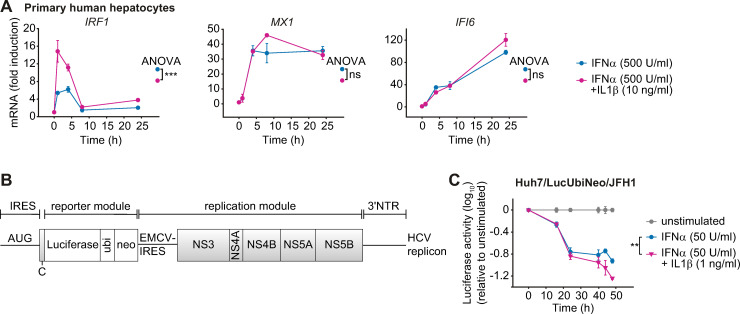
Co-stimulation with IFNα and IL1β enhances IFNα-induced gene expression in primary human hepatocytes and viral clearance of HCV in a replicon cell line.(A) Effect of co-stimulation with IFNα and IL1β on mRNA expression of IFNα-induced genes in primary human hepatocytes. Cells were stimulated with 500 U/ml IFNα alone or co-treated with 500 U/ml IFNα and 10 ng/ml IL1β. RNA was extracted at the indicated time points and analyzed by qRT-PCR. Triplicate samples were analyzed from three different donors and error bars represent SD. (B) Scheme of the bicistronic subgenomic HCV reporter RNA (replicon). IRES, internal ribosomal entry site; NTR, non-translated region. (C) Enhanced suppression of HCV replication in cells co-stimulated with IFNα and IL1β. Huh7/HCV/Luc replicon cells were stimulated with 50 U/ml IFNα alone or were co-treated with 50 U/ml IFNα and 1 ng/ml IL1β. The values are relative to the unstimulated control. Error bars represent the SEM of six technical replicates.